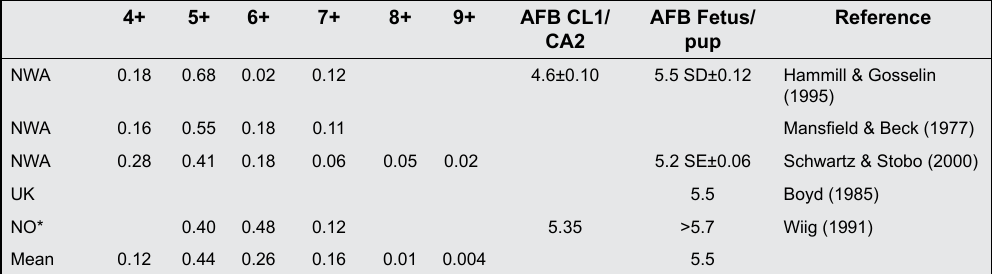
Table 2. Ages at first birth (AFB) in North West Atlantic (NWA), British (UK), and Norwegian (NO) grey seals, as based on data on actual birth rates, presence of fetuses, and Corpora Lutea (CL) or Corpora Albicantia (CA). Note that estimates based on corpora are strongly biased